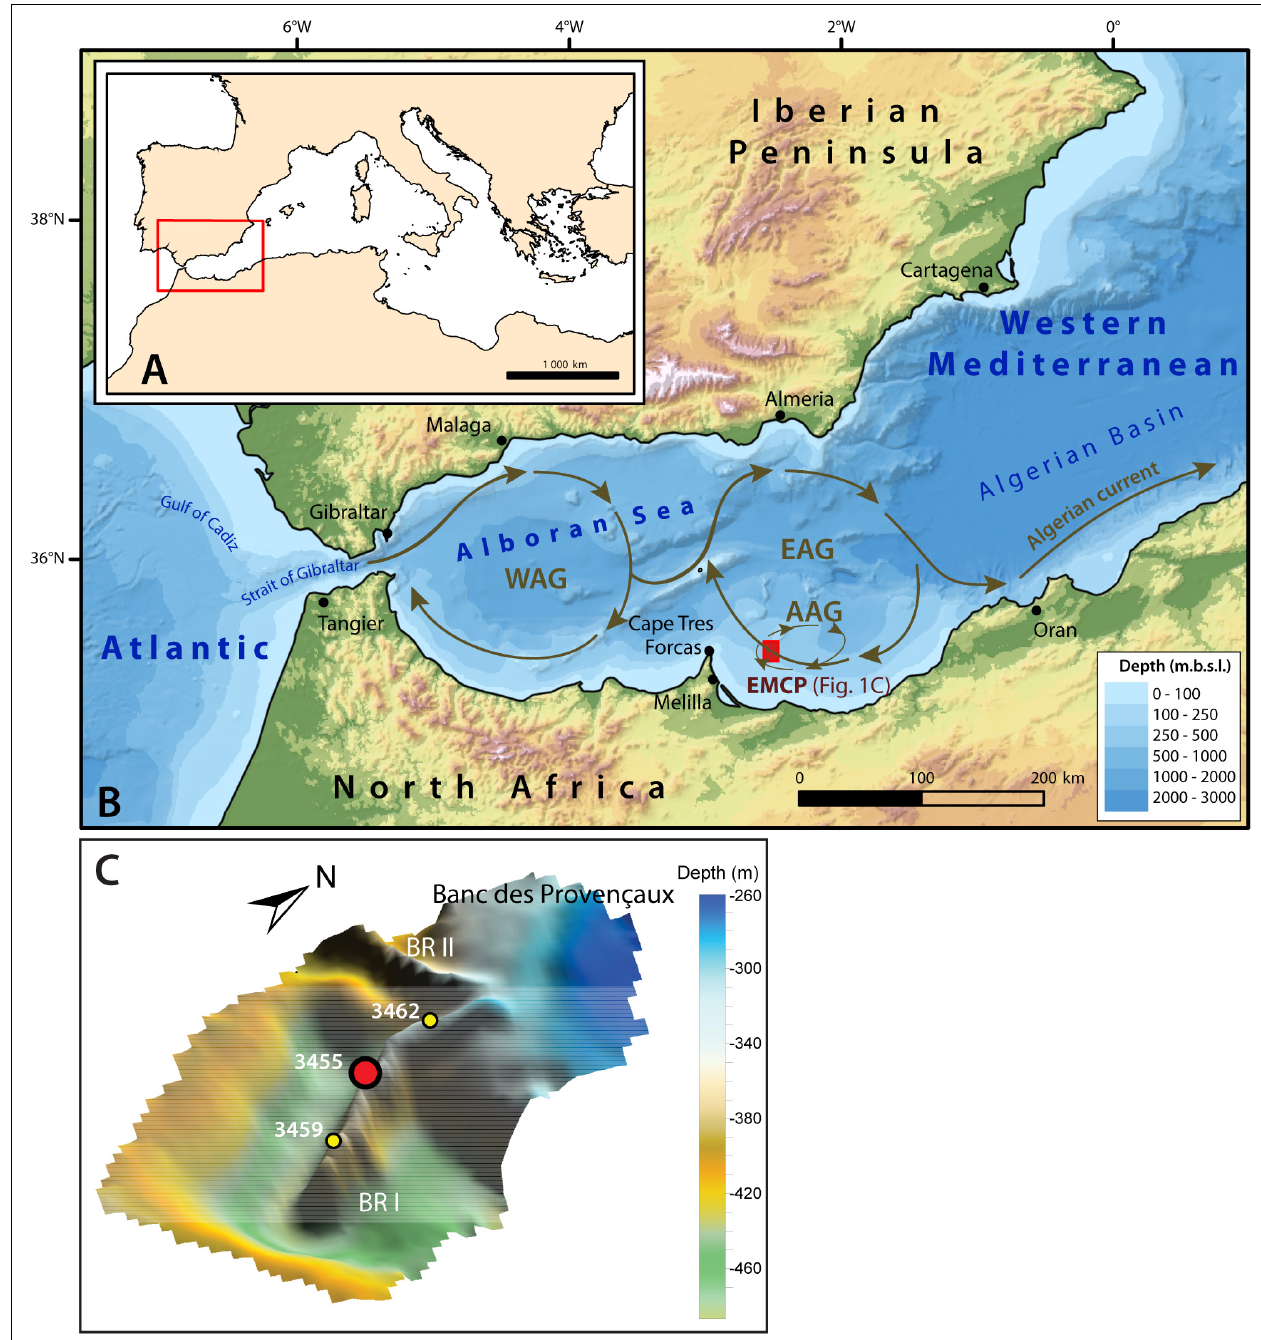
FIGURE 1 | Location and oceanographic circulation of the study area. (A) General map of the Mediterranean Sea and location of the western Mediterranean (red rectangle). (B) Bathymetric map of the western Mediterranean. The red box east of the Cape Tres Forcas indicates the location of the East Melilla Coral Province (EMCP). The bold brown arrows illustrate the general circulation of the inflowing surface Modified Atlantic Water (MAW), which describes two anticyclonic gyres: the Western Alboran Gyre (WAG) and the Eastern Alboran Gyre (EAG). The Atlantic Anticyclonic Gyre (AAG) is illustrated by the thin brown arrows. The surface water circulation is based on a compilation of results from Lanoix (1974), Tintore et al. (1988), Viúdez and Tintoré (1995) and L’Helguen et al. (2002), whist the bathymetry uses the GEBCO_2019 gridded bathymetric data. (C) Precise location of the Banc des Provençaux and Brittlestar Ridge I and II (BR I and BR II). The location of the studied core MD13-3455G is illustrated by the red dot, whereas the two yellow dots indicate the location of the neighboring cores MD13-3459G and MD13-3462G sampled during the same cruise. This map uses MultiBeam Echosounder data retrieved during the “GATEWAY” cruise (N ◦ 194) onboard the Marion Dufresne II Research Vessel (van Rooij et al.,